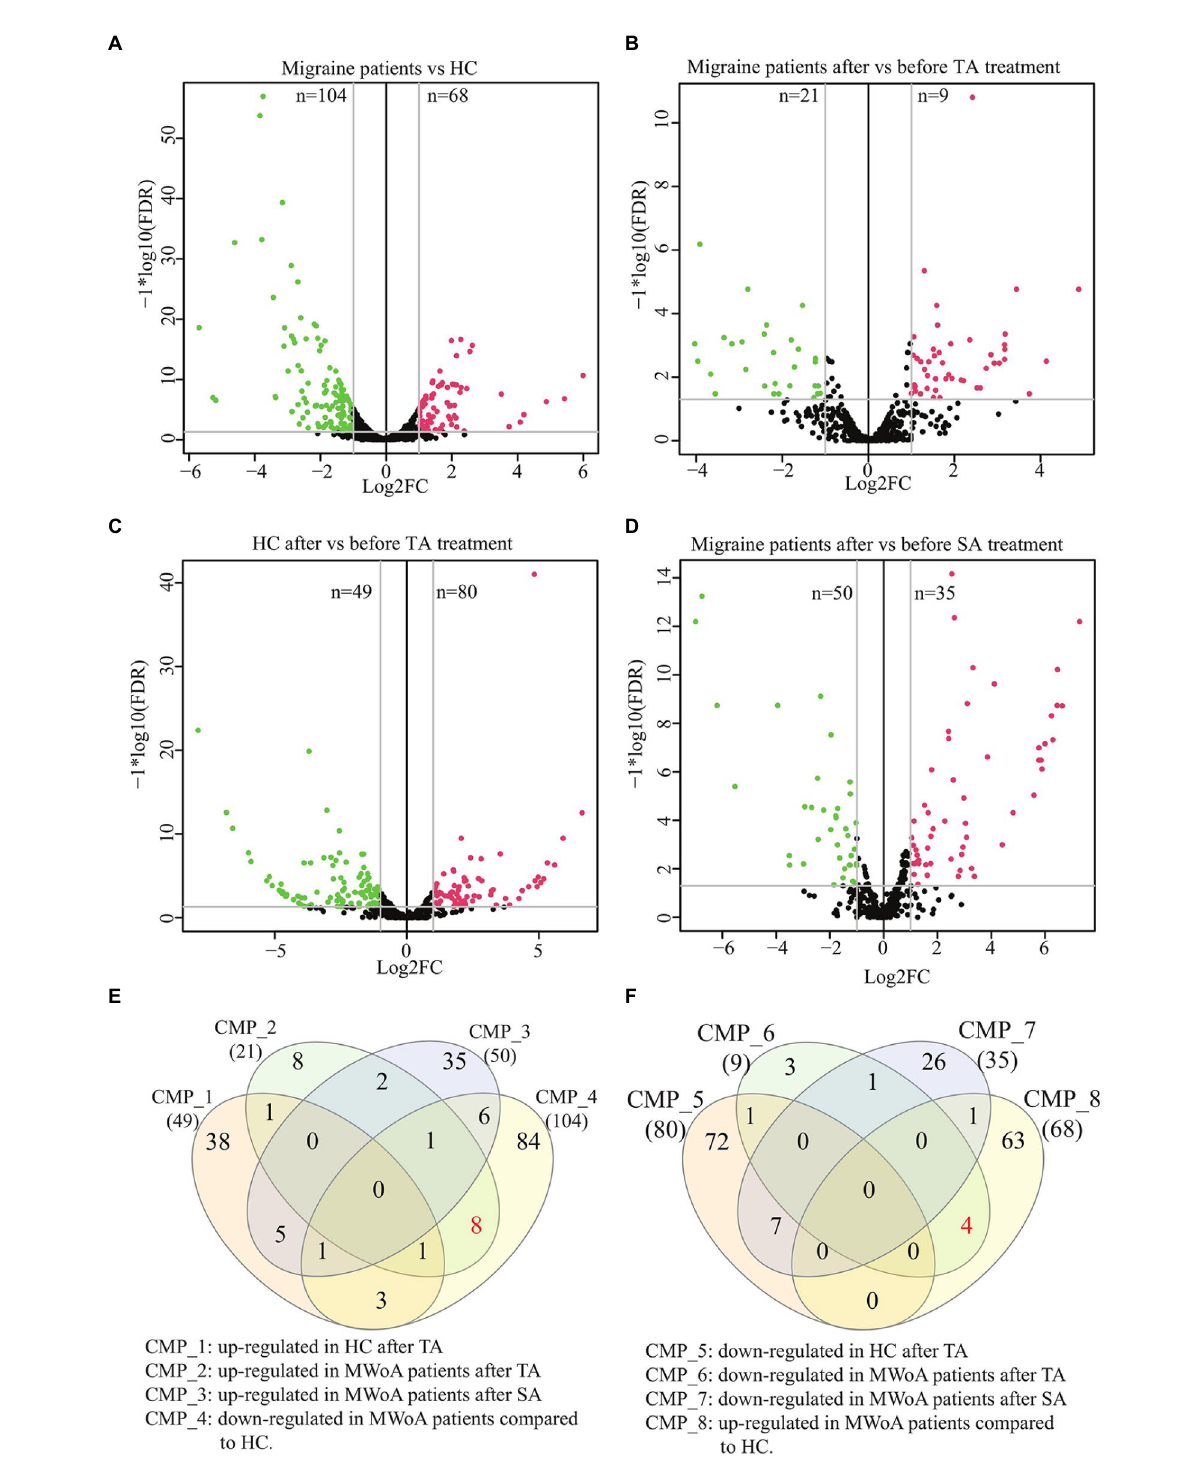
FIGURE 3 Volcano plots and Venn diagram of DEmiRs in MWoA patients and HC volunteers before and after treatment. (A) Volcano plot of DEmiRs between migraine patients and HC. (B) Volcano plot of DEmiRs in migraine patients before and after TA treatment. (C) Volcano plot of DEmiRs in HC before and after TA treatment. (D) Volcano plot of DEmiRs in migraine patients before and after SA treatment. (E) Venn diagram of miRNAs up-regulated in HC after TA, up-regulated in MWoA patients after TA, up-regulated in MWoA patients after SA and down-regulated in MWoA patients compared to HC. (F) Venn diagram of miRNAs down-regulated in HC after TA, down-regulated in MWoA patients after TA, down-regulated in MWoA patients after SA and up-regulated in MWoA patients compared to HC. MWoA, migraine without aura patients; HC, healthy control; TA, true acupuncture; SA, sham acupuncture; FDR, false discovery rate; log2FC, log2 fold change; CMP,